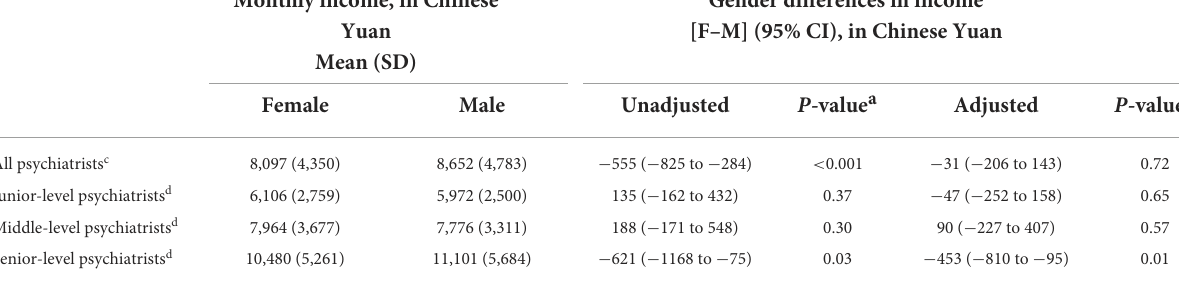
TABLE 2 Multivariable linear regression analyses on gender differences in income, adjusted with inverse probability of treatment